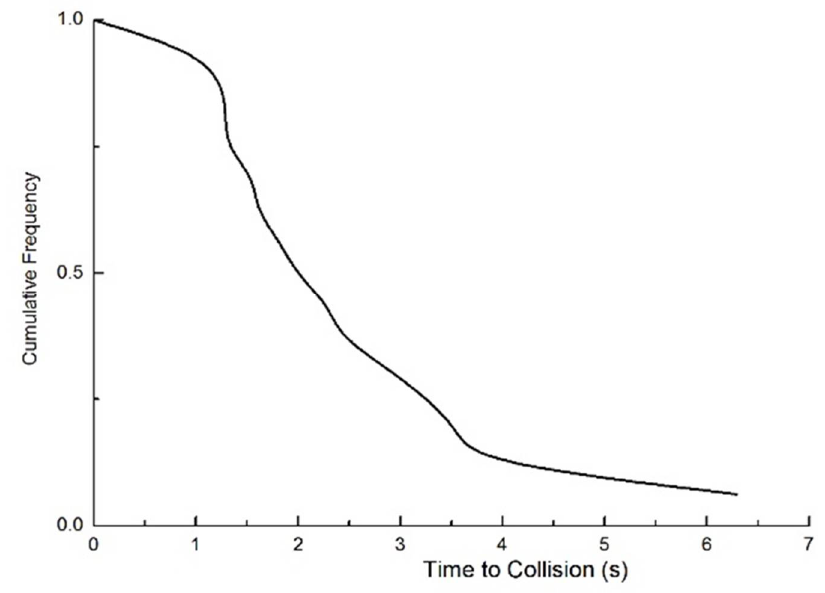
Figure 3. TTC cumulative frequency chart.